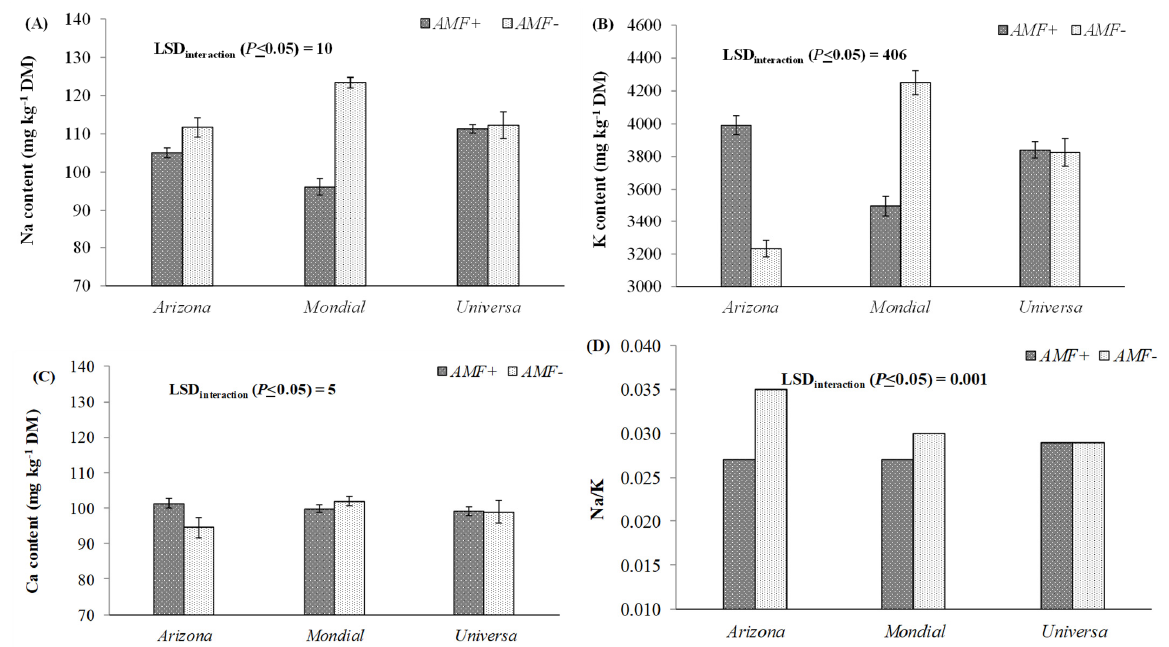
Figure 1. Effect of “soil mycorrhization × cultivar” interaction on the tuber levels of Na ( A ), K ( B ), Ca ( C ), and Na/K ( D ). Data are presented as mean ± standard deviation. The ± standard deviation of ratio Na/K is ≤ 0.001. AMF+: mycorrhizal inoculated plots; AMF − : non-mycorrhizal inoculated plots.